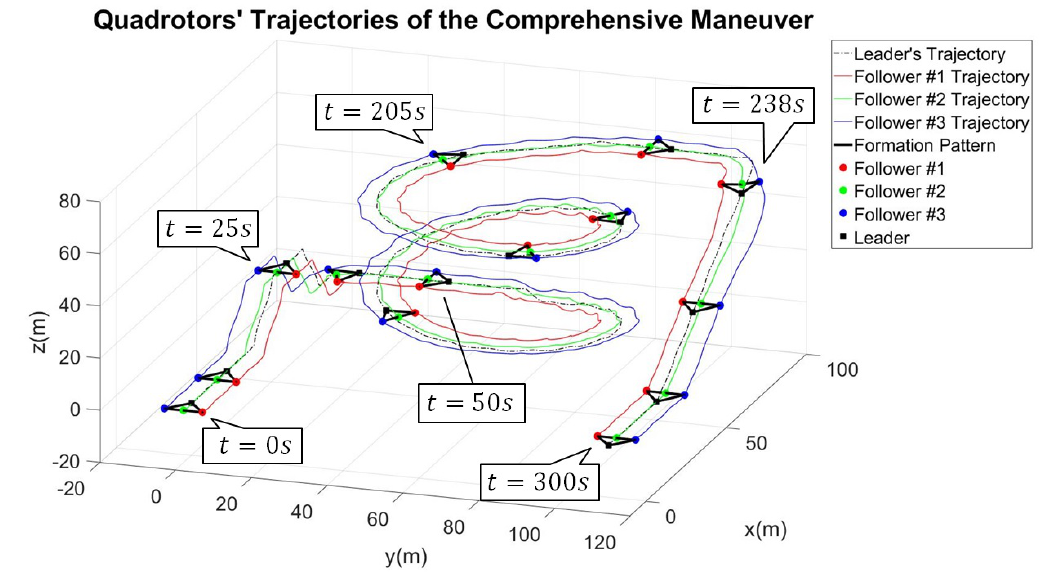
Figure 13. Quadrotor trajectories of comprehensive